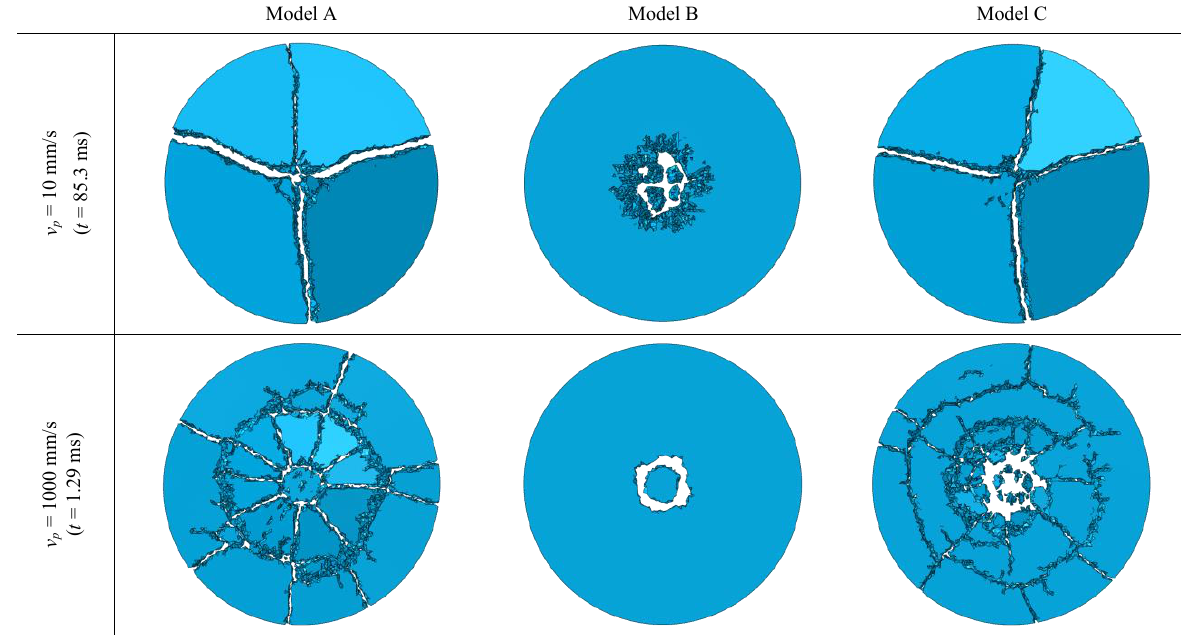
Table 4: Glass fragmentation (bottom view) for ring-on-ring test simulations performed for all three considered JH-2